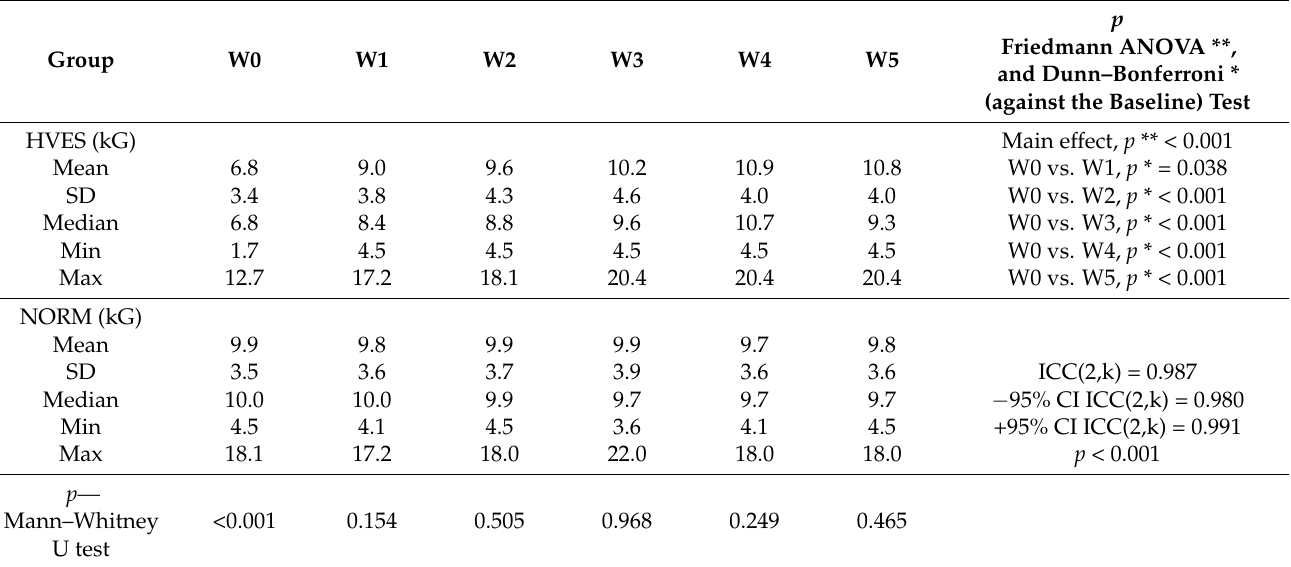
Table 3. The dynamometric measurement of wrist flexor strength. ICC, interclass correlation coeffi- cient model (for six trials of the wrist flexors strength). Abbreviations: W0, baseline (before treatment); W1, after treatment; W2, 3 weeks after treatment; W3, 6 weeks after treatment; W4, 12 weeks after treatment; W5, 24 weeks after treatment.